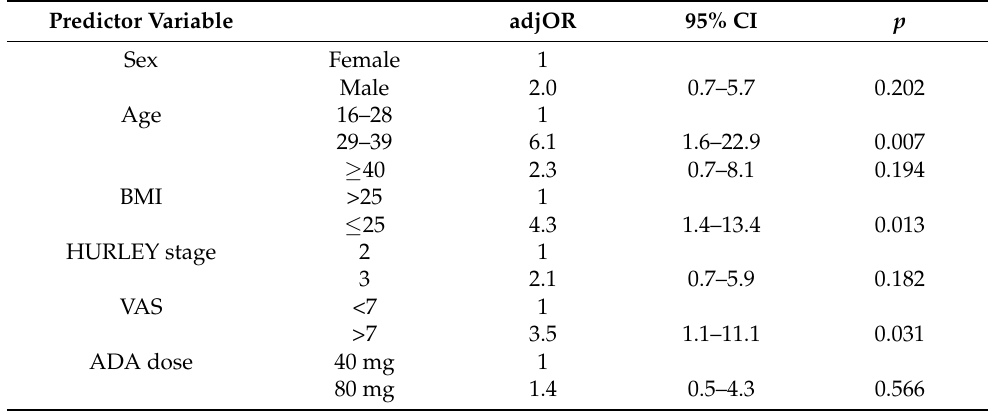
Table 3. Multiple logistic regression models: relative odds of reaching the MCID at T32. Predictor